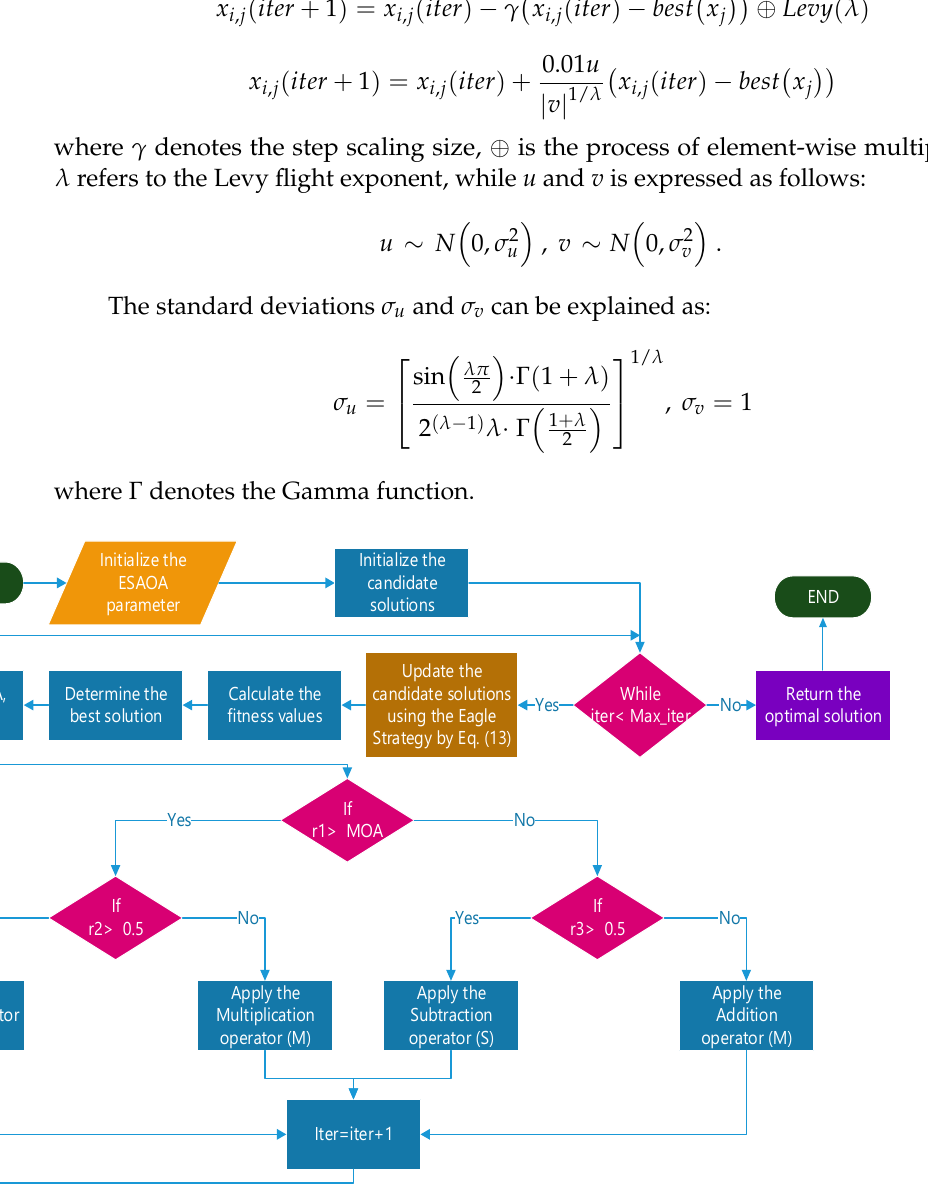
Figure 8. Flowchart of the proposed ESAOA technique.